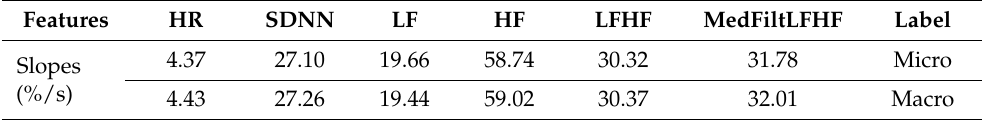
Table 4. Sensitivity of feature quality to HBI error in terms of classifier mean error slopes (units: percent error per second of HBI